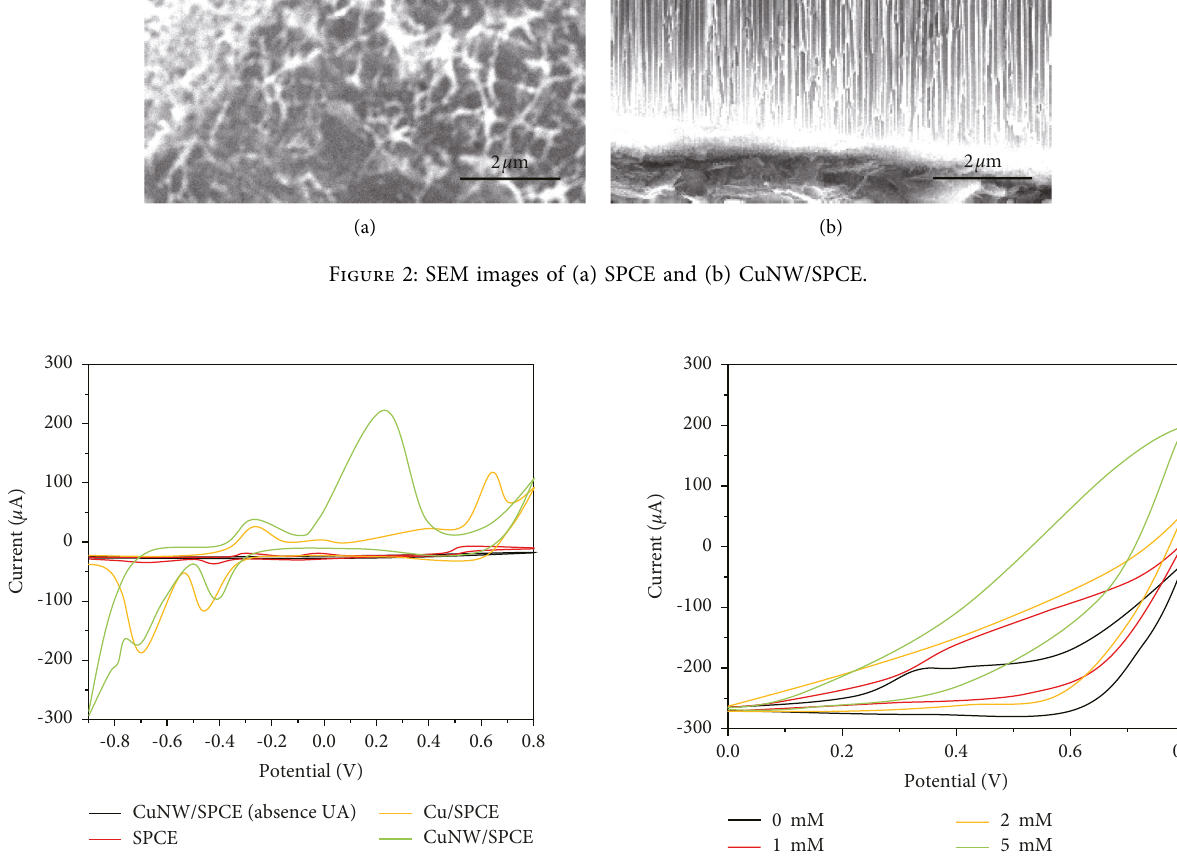
Figure 3: CVs of bare SPCE, Cu/SPCE, and CuNW/SPCE towards 2mM UA (0.1M NaOH, scan rate 25mV/s).